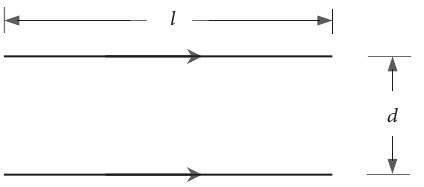
Figure 9: Features of two ideal parallel conductors of no straight section for measuring mutual induction.